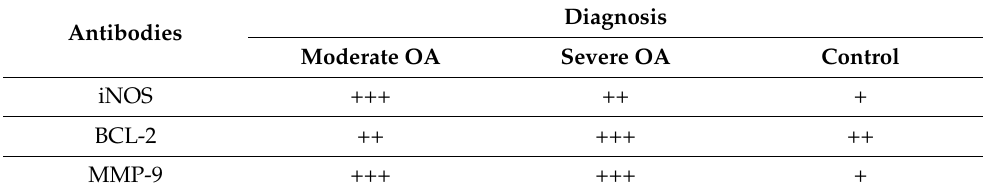
Table 3. Staining intensity to specific antibodies in moderate OA, severe OA and